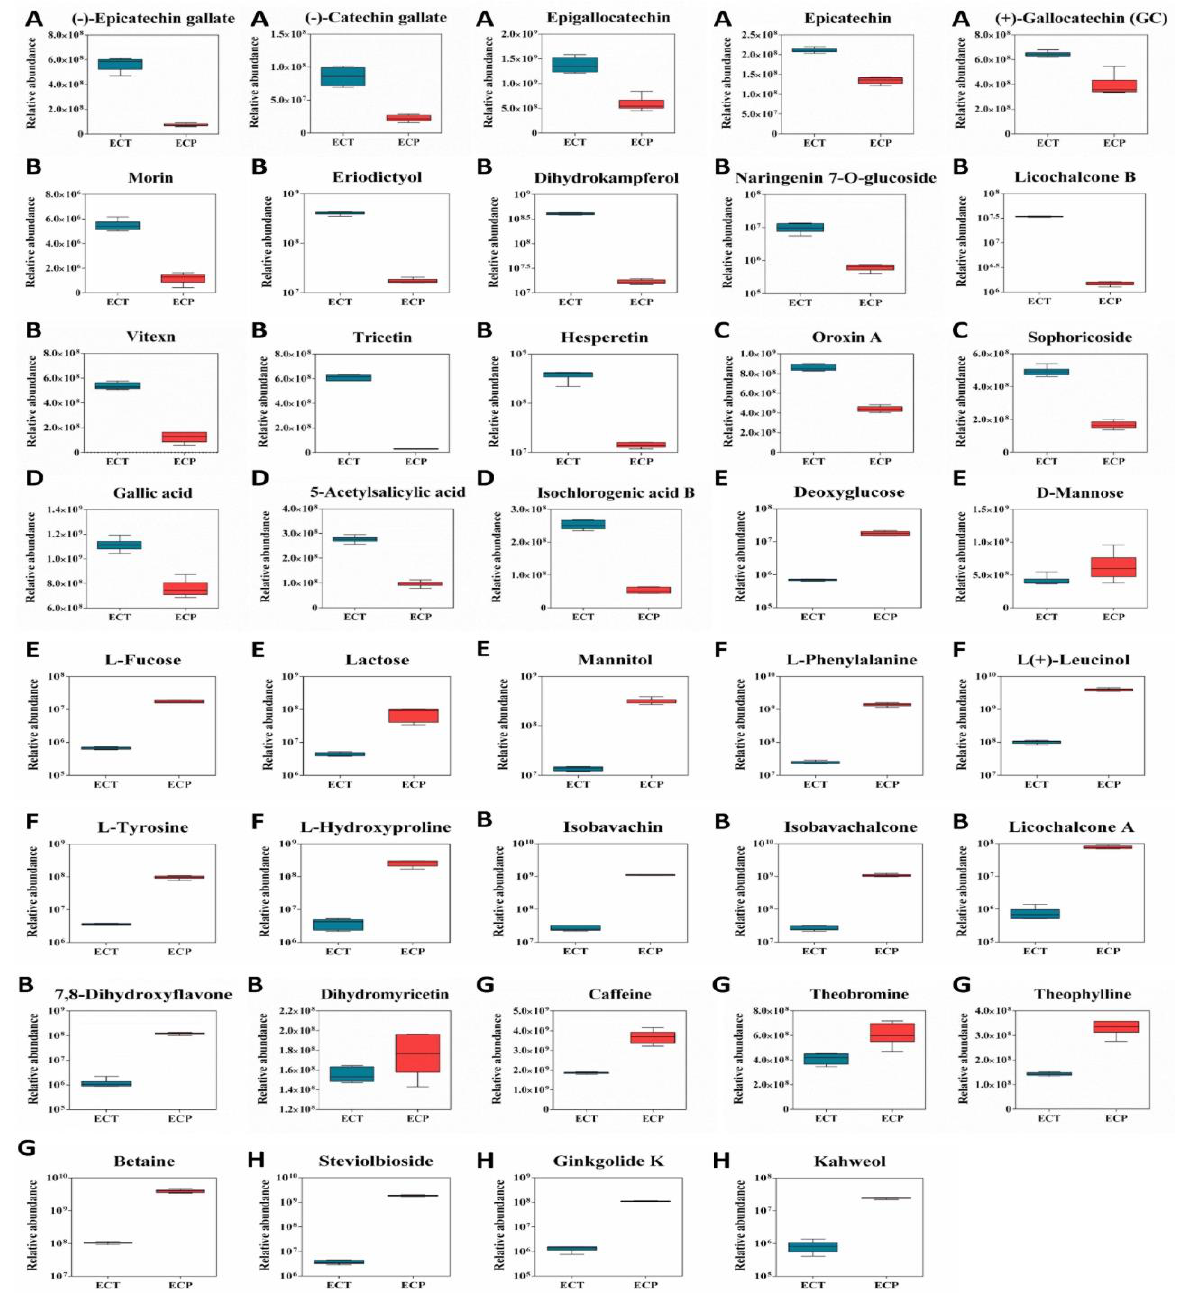
Figure 4. 39 differential metabolites box diagram of ECT and ECP. ( A ): Catechin; ( B ): flavonoids; ( C ): flavonoids; ( D ): flavonoids; ( E ): flavonoids; ( F ): amino acids; ( G ): alkaloids; ( H ): other metabo- lites.